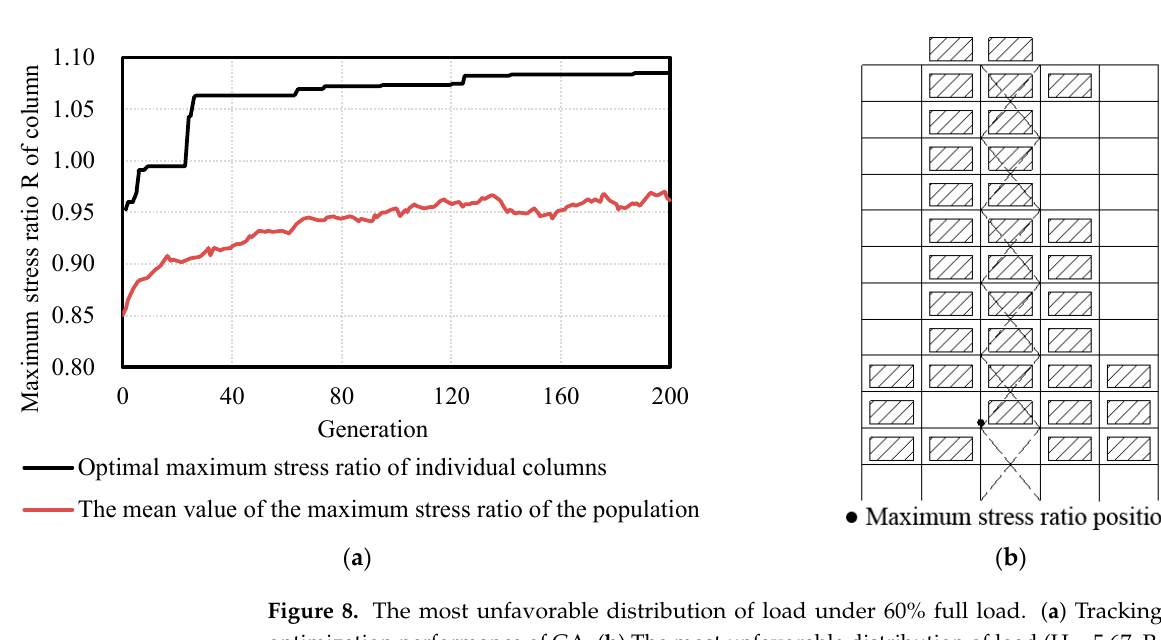
Figure 7. The most unfavorable distribution of load under 70% full load. ( a ) Tracking chart of optimization performance of GA. ( b ) The most unfavorable distribution of load (H = 5.90, P = 0.36).